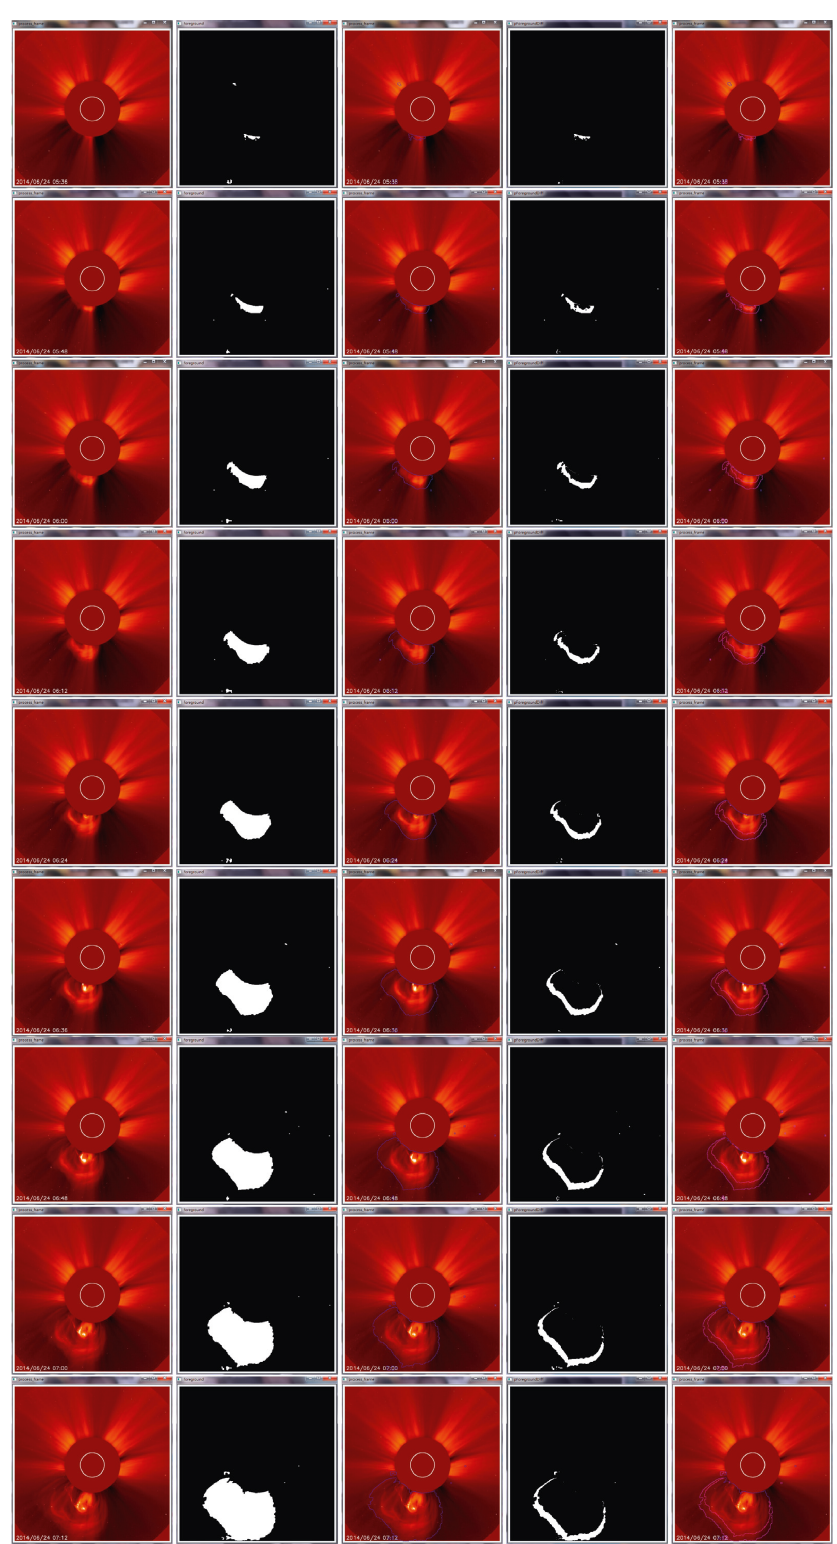
Figure 7: Morphological change description graph of a CME event (appearance date-time (UT): 2014/06/24 05: 36:05) by using the intermediate images of our propose